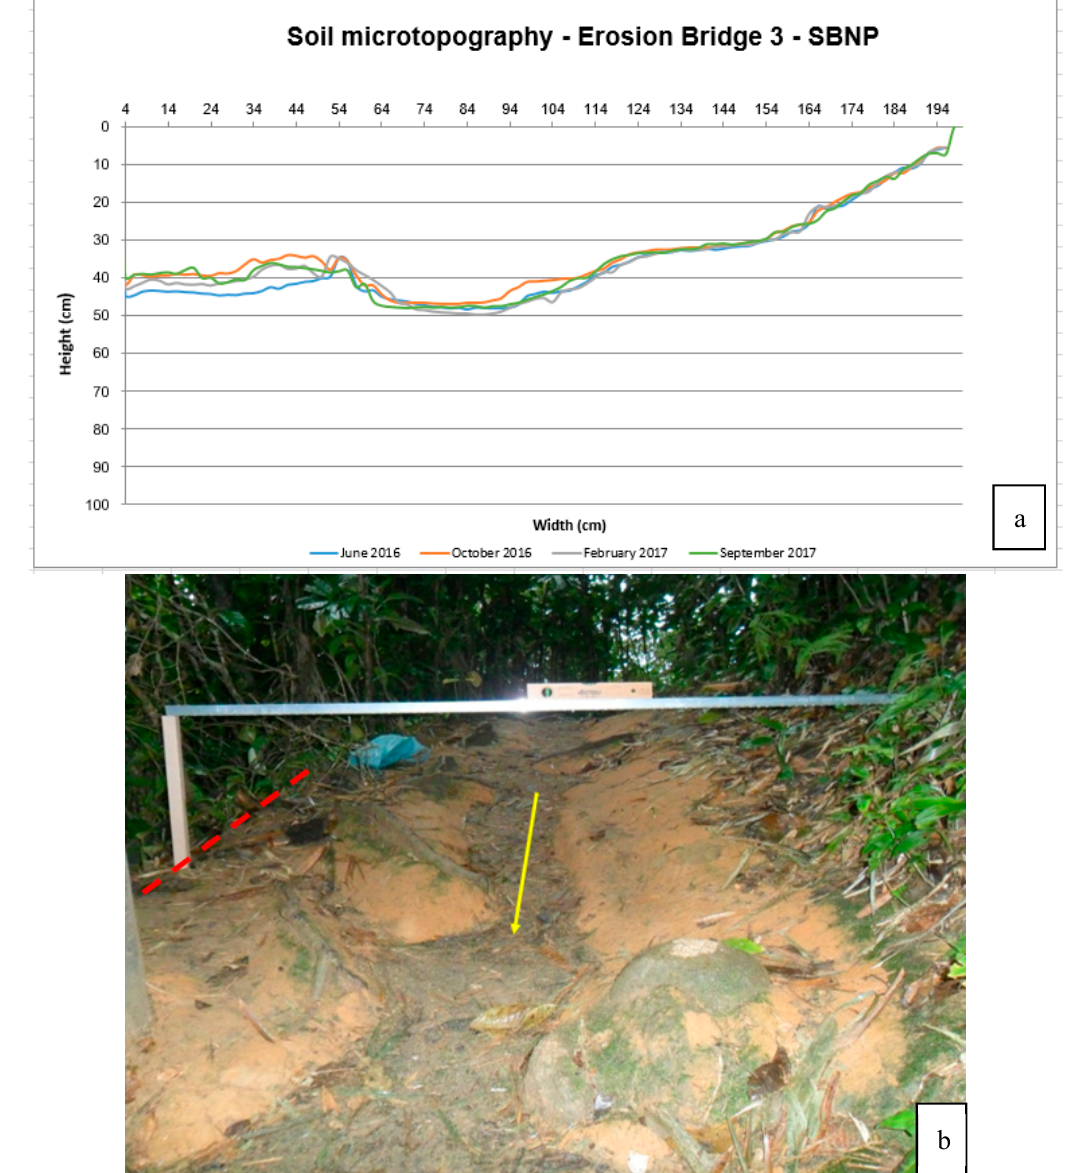
Figure 7. ( a ) Soil microtopographic analysis between June 2016 and September 2017 on EB3. ( b ) The yellow arrow indicates a rill with litter accumulation and the red line indicates erosion on the edge of the trail. Photo: L. Rangel (2017).